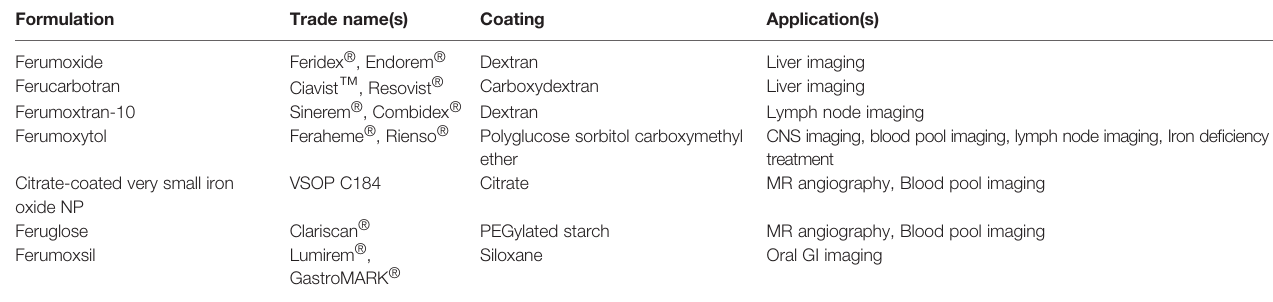
TABLE 1 | Selected IONP-based contrast agents for MRI.